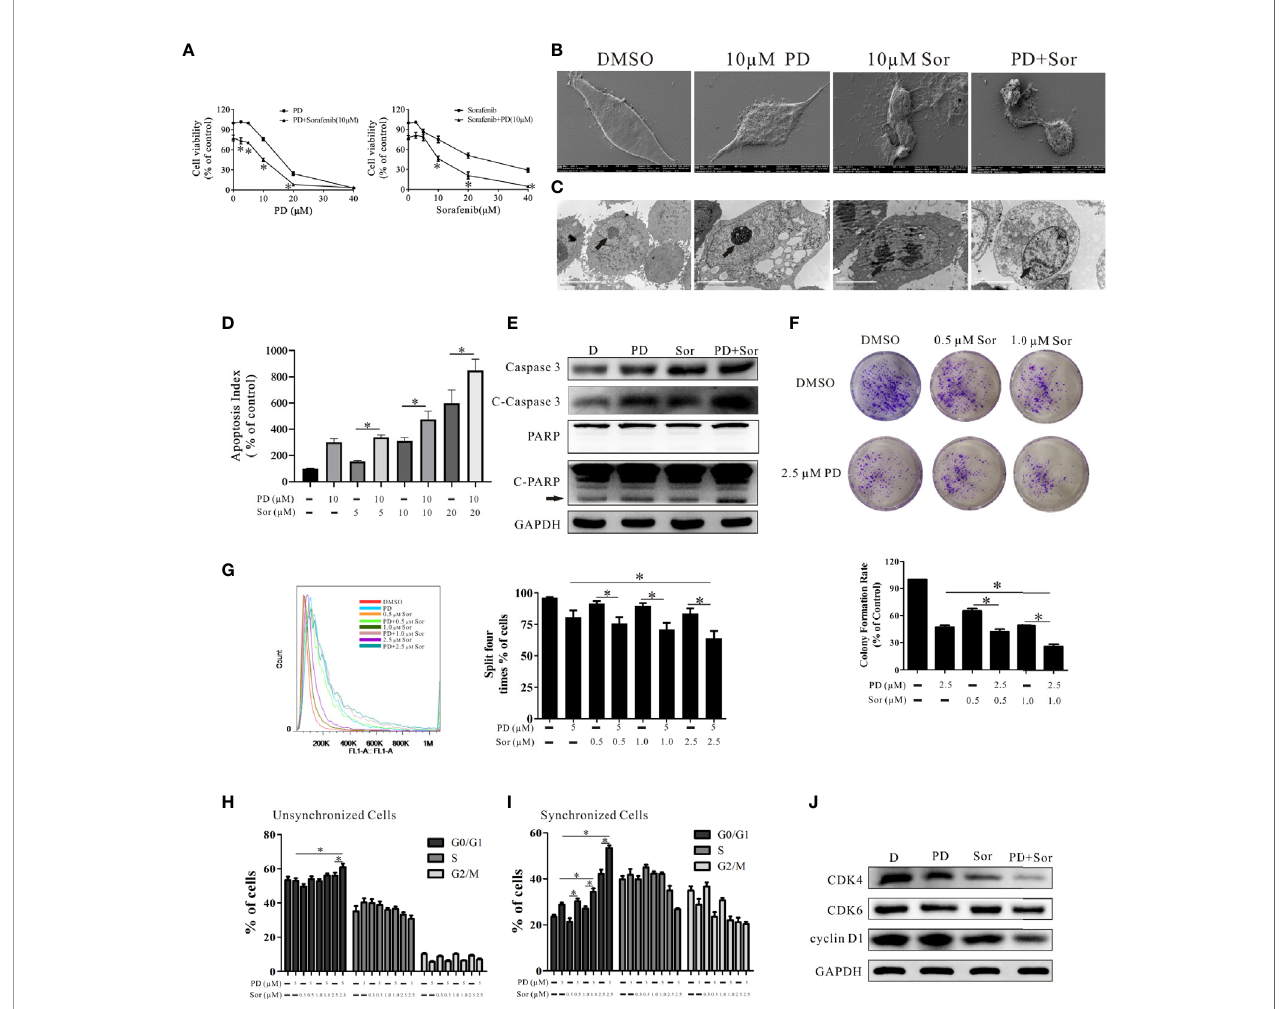
FIGURE 1 | PD promotes the anti-tumor effects of sorafenib in PC3 cells. (A) . The effects of PD, sorafenib and PD plus sorafenib on cell viability. (B, C) . The changes in the cell membrane and nucleus after treatment with PD alone, sorafenib (Sor) alone or PD plus sorafenib. (D) . The induction of apoptosis by PD, Sor and PD + Sor. (E) . The protein expression levels of Caspase 3, C-Caspase 3, PARP and C-PARP were examined after cells were treated with 10 m M PD alone, 10 m M sorafenib alone or PD plus sorafenib for 6 h. (F) . The ability of cells to achieve colony growth was assessed after treatment with PD alone, sorafenib alone or PD plus sorafenib for 10 days. (G) . The proliferation of cells was monitored using the CFDA SE assay after treatment with PD alone, sorafenib alone or PD plus sorafenib for 5 days. (H, I) . The cell cycle distribution of PC3 cells following treatment with PD alone, sorafenib alone or PD plus sorafenib for 24 h after pre-treatment with (H) or without (I) 2 mM thymidine. (J) . Changes in the protein expression levels of CDK4, CDK6 and cyclin D1 after treatment with 5 m M PD alone, 2.5 m M sorafenib alone or PD plus sorafenib for 24 h. * p <